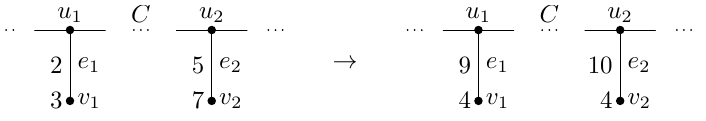
and vertices v 1 , e 2